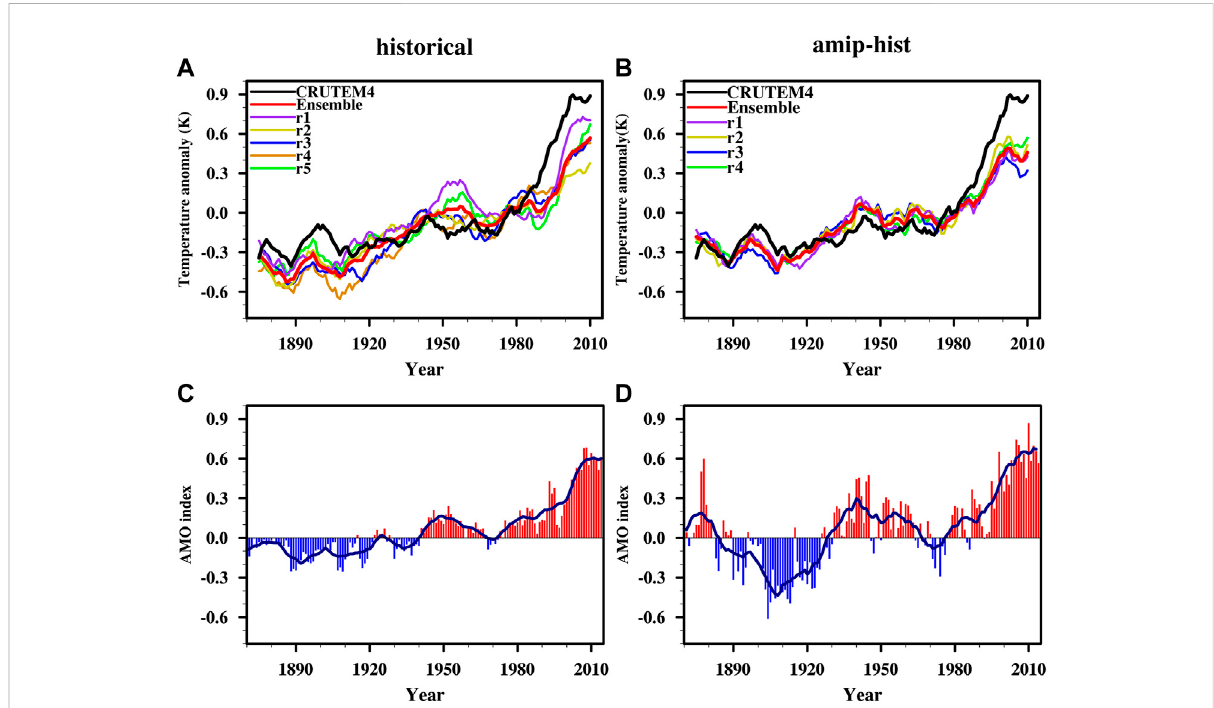
FIGURE 3 Same as Figure 2 but with 11-year running average for the (A) coupled and (B) uncoupled simulations (black line: CRUTEM4; red line: ensemble mean); annual SST anomalies (units: K; relative to 1961 – 1990 mean) averaged over the North Atlantic (0 to 60 ° N, 0 to 80 ° W) from 1870 to 2014 by the (C) coupled model and (D) observation. The dark blue heavy line depicts the AMO and is from 11-year running average.